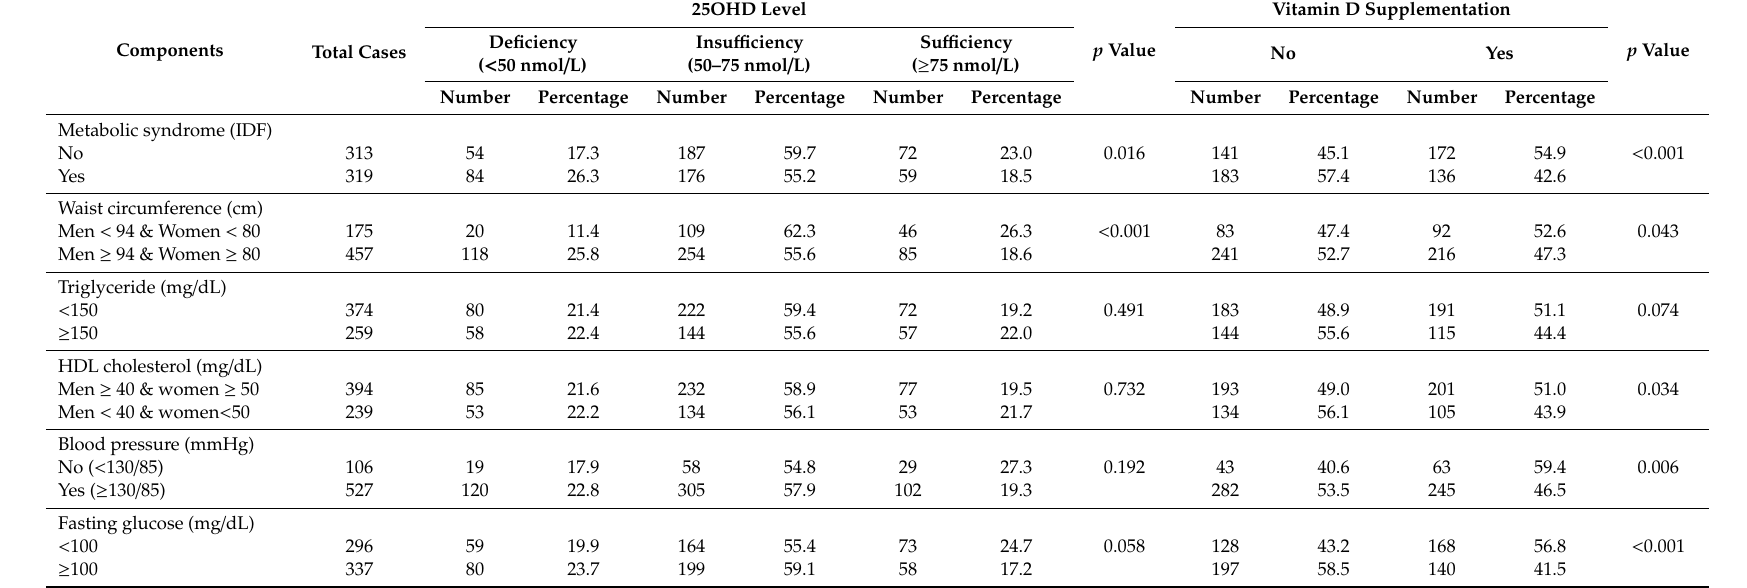
Table 3. 25OHD level in relation to metabolic syndrome, waist circumference, triglyceride, HDL cholesterol, blood pressure, and fasting